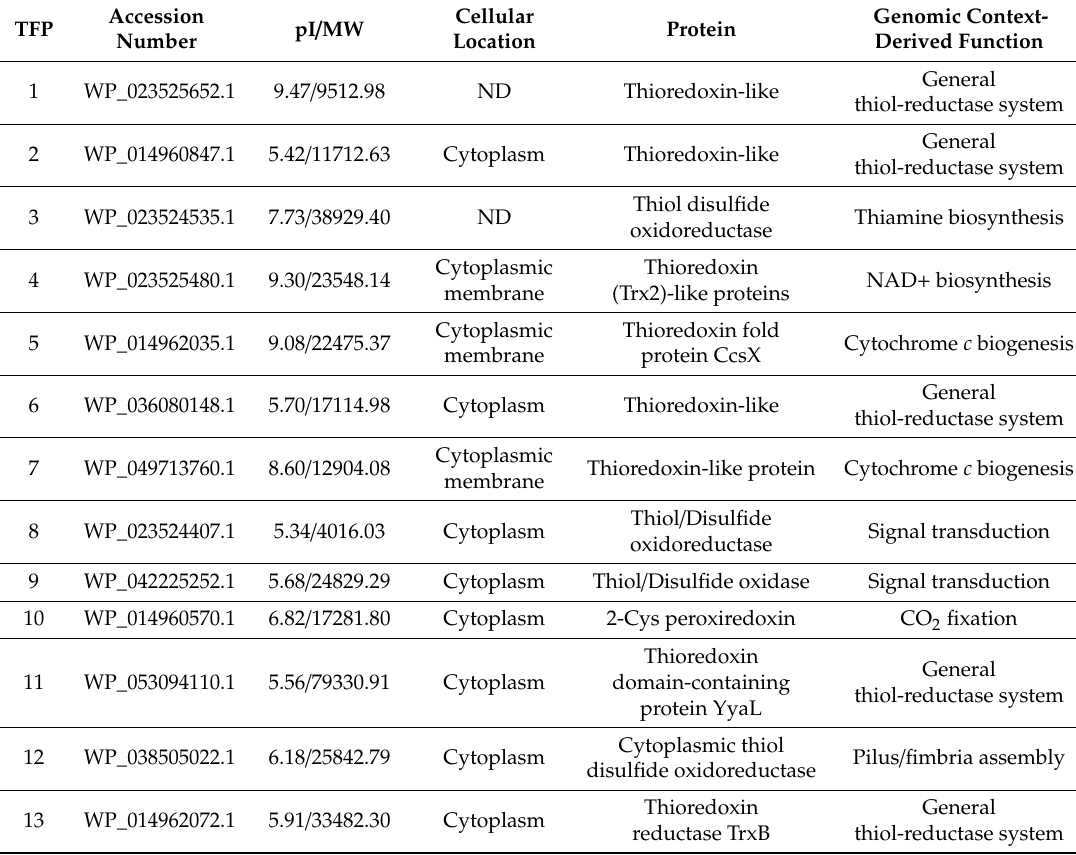
Bioinformatic characterization of the predicted thioredoxin fold protein (TFP) of Leptospirillum sp.